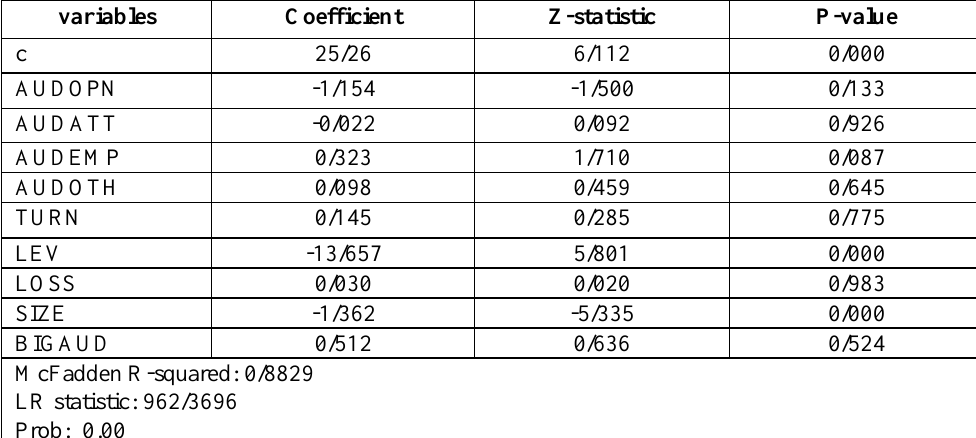
Table 3. The results of data analysis for testing research